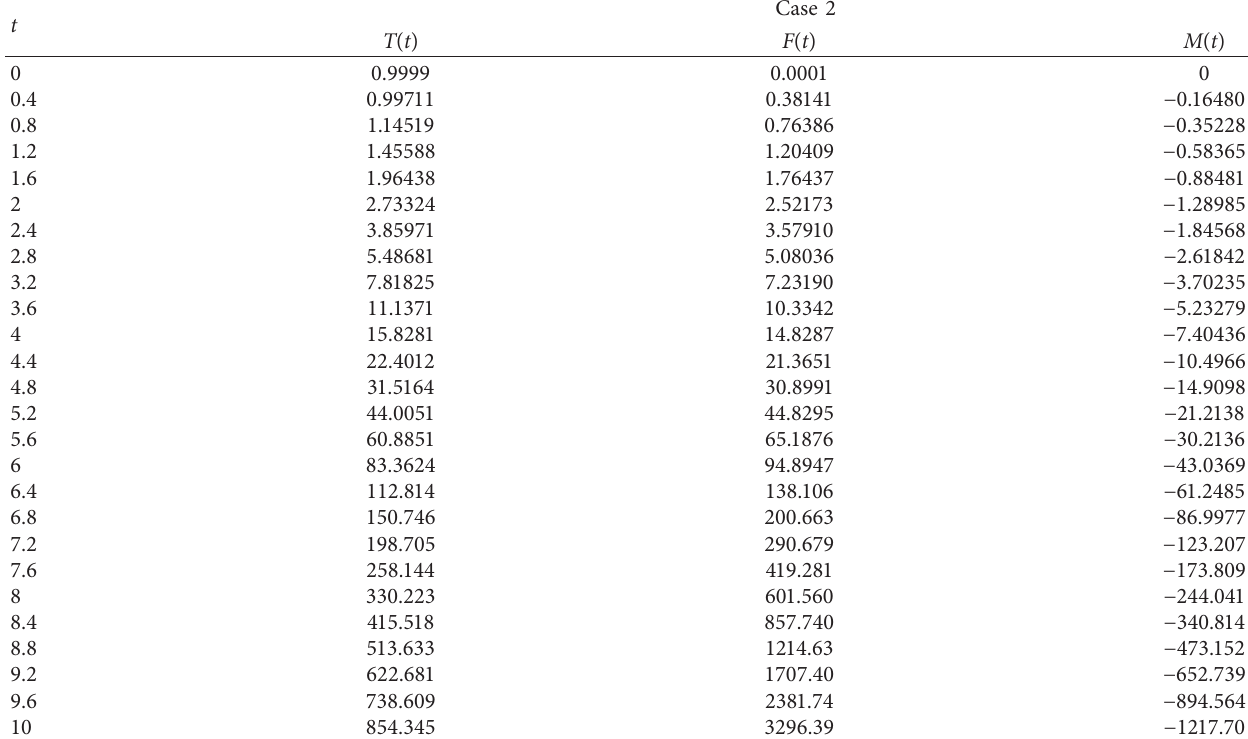
Table 3: Numerical investigations of the obtained results T ( t ), F ( t ), and M ( t ) for Case 2 of the TFM